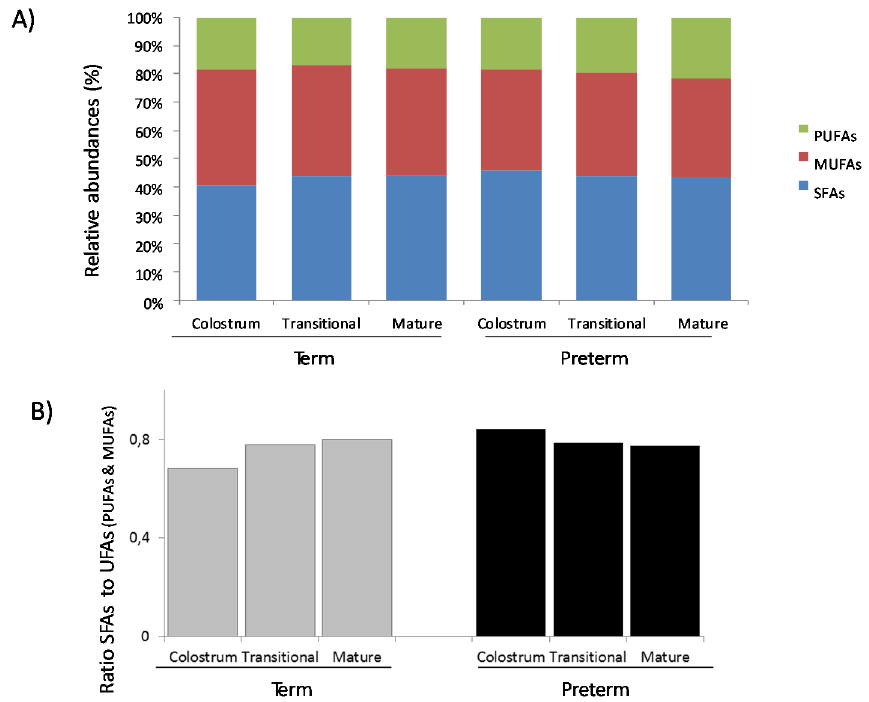
Figure 1. Relative abundances (%) of fatty acids (FAs) (Panel A) and ratio of saturated (SFAs) to unsaturated-UFAs (PUFAs and MUFAs) fatty acids (Panel B) present in breast milk samples according to gestational age and lactation stage.